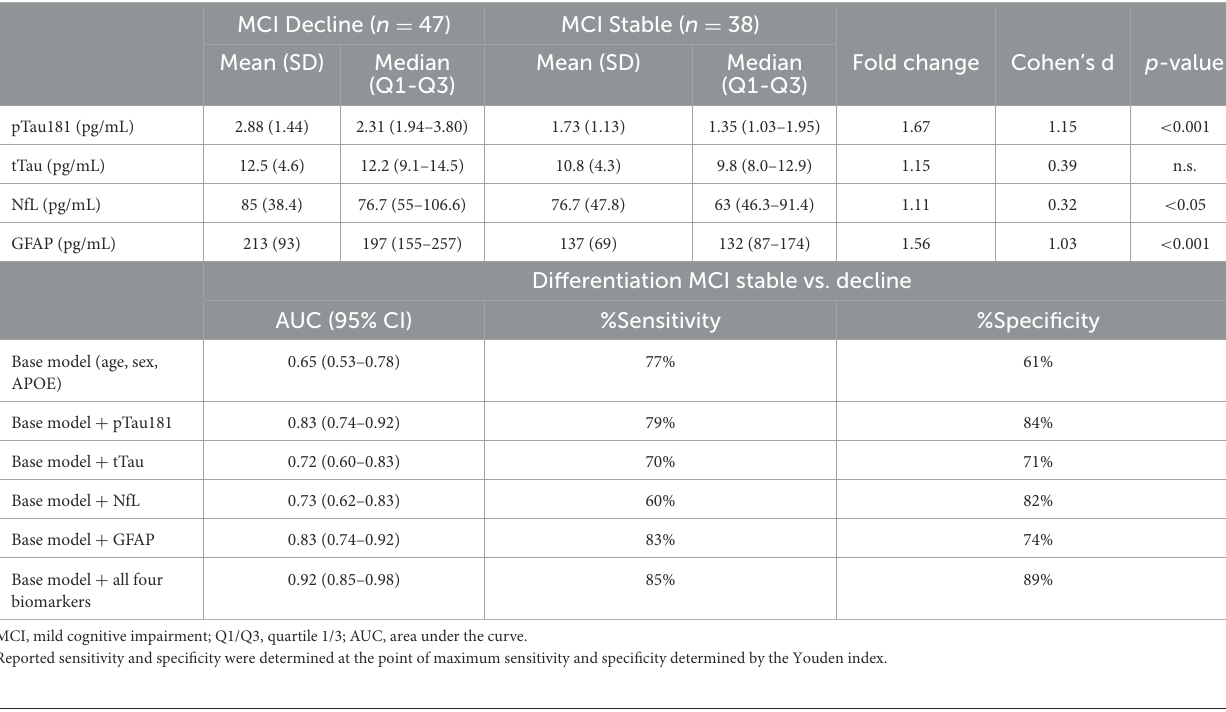
CDR (rho = 0.19; p < 0.06), while no associations were observed for pTau181 or